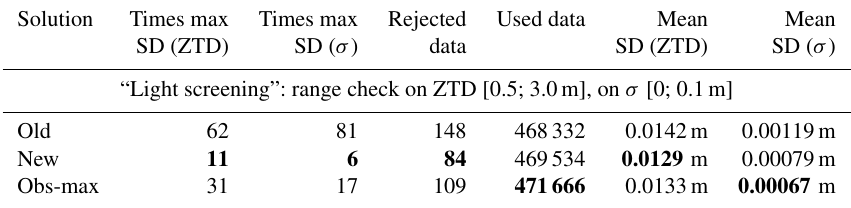
Table 2. Statistics of ZTD estimates and formal errors ( σ ) for all three processing variants discussed in the text, computed over 104 common ASG-EUPOS stations. The best values are indicated in bold. Column 2 (respectively 3) gives the number of stations for which the standard deviation of ZTD (respectively σ ) is maximum among the three solutions (e.g. standard deviation of ZTD of the old solution is maximum 62 × out of